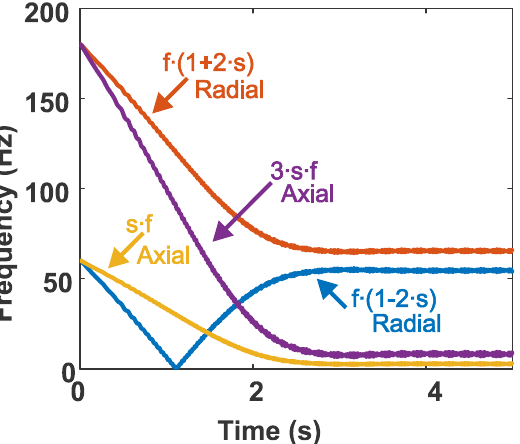
Figure 2. Evolutions of fault components related with broken rotor bars in the magnetic stray flux and current signals during the startup transient.